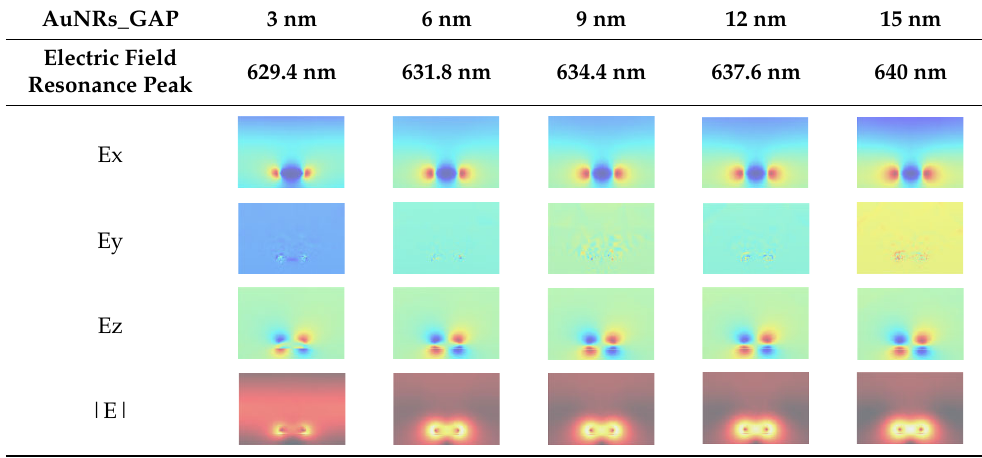
Table 3. Electric field distribution under the resonance peak of the gold nanorod dimer in the juxtaposed structure (X-Z section).